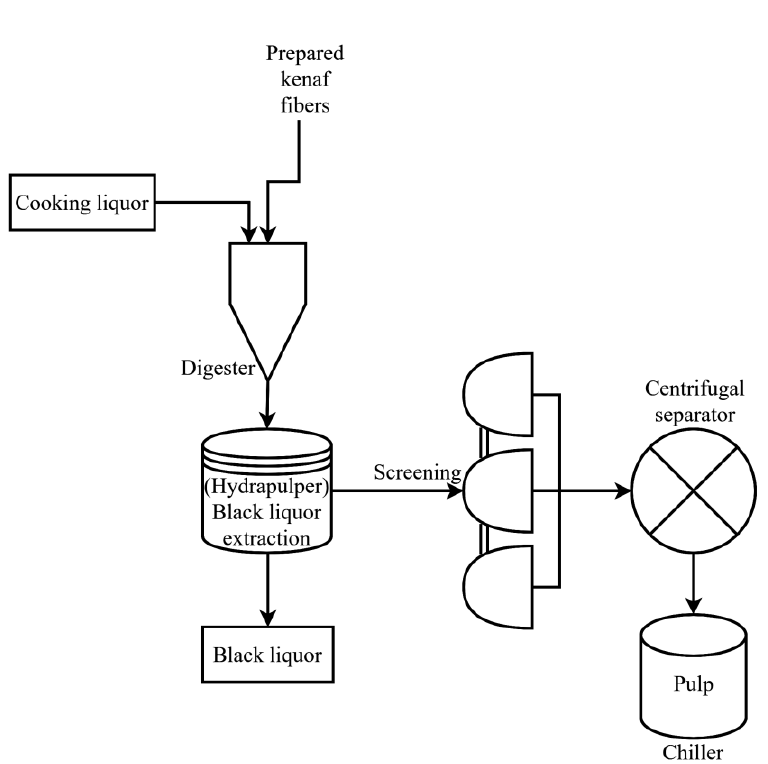
Figure 2. Pulping process of Kenaf fibers.